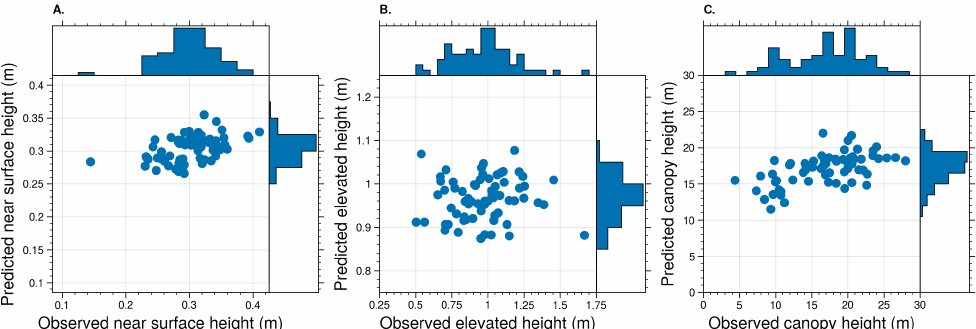
Figure 5. Joint plots showing fuel height observed using TLS point clouds and mean prediction from the random forest models trained with TLS observations for ( A ) near-surface ( B ) elevated ( C ) canopy fuel